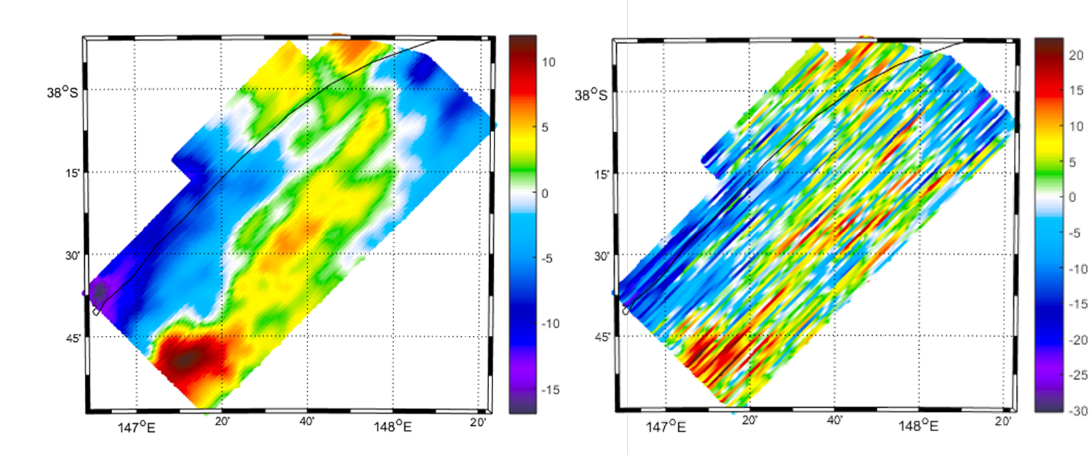
Figure 5. Reference field ( left ) and simulated observations ( right ).The black line represents the shoreline, where the land is located in the northwest and the sea in the south. Unit [mGal].